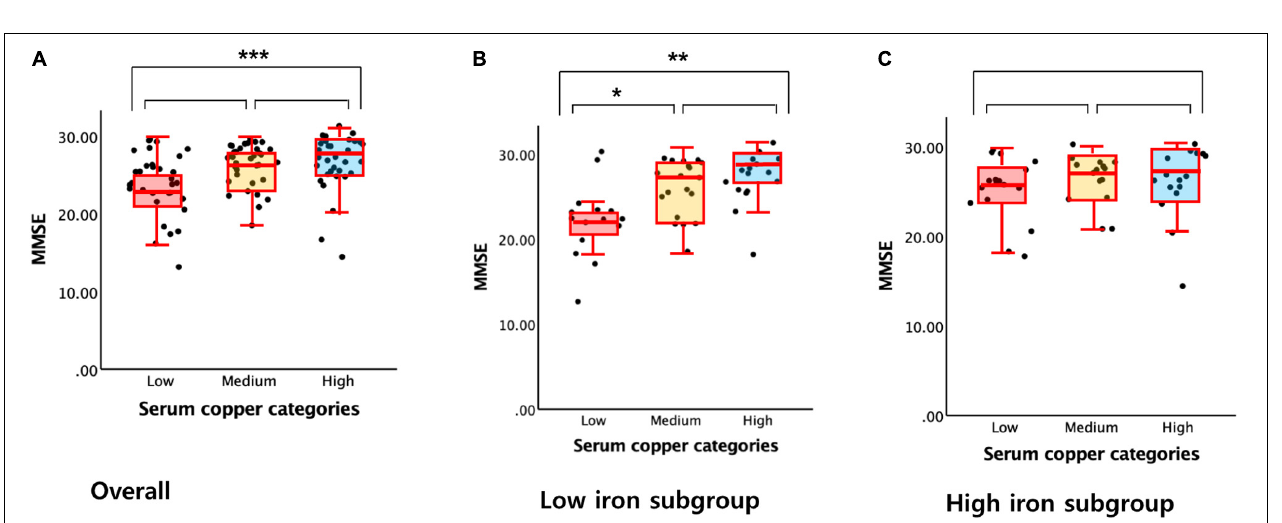
Frontiers in Aging Neuroscience |